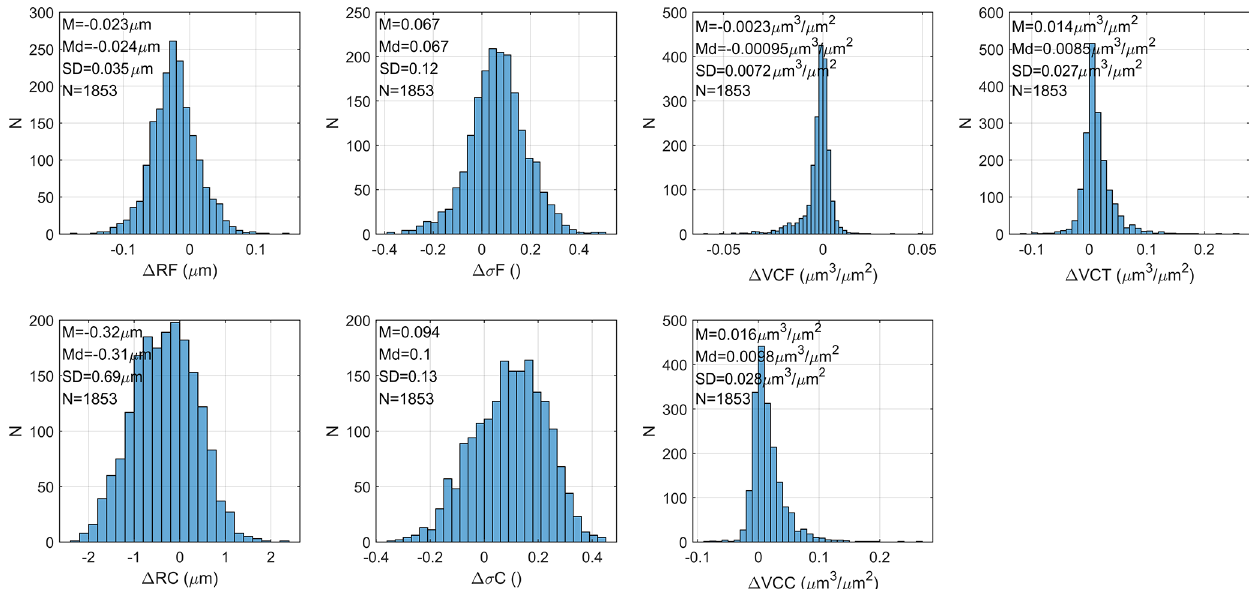
Figure 14. Frequency histograms of the (cid:49) differences in the aerosol size distribution properties retrieved by GRASP with the single-pixel approach (GRASP-CAM) and the ones retrieved by AERONET. The mean (M), median (Md) and standard deviation (SD) of these differences are also shown. These size distribution properties are volume median radius of fine (RF) and coarse (RC) modes, standard deviation of log- normal distribution for fine ( σ F) and coarse ( σ C) modes, and aerosol volume concentration for fine (VCF) and coarse (VCC) modes and the total value